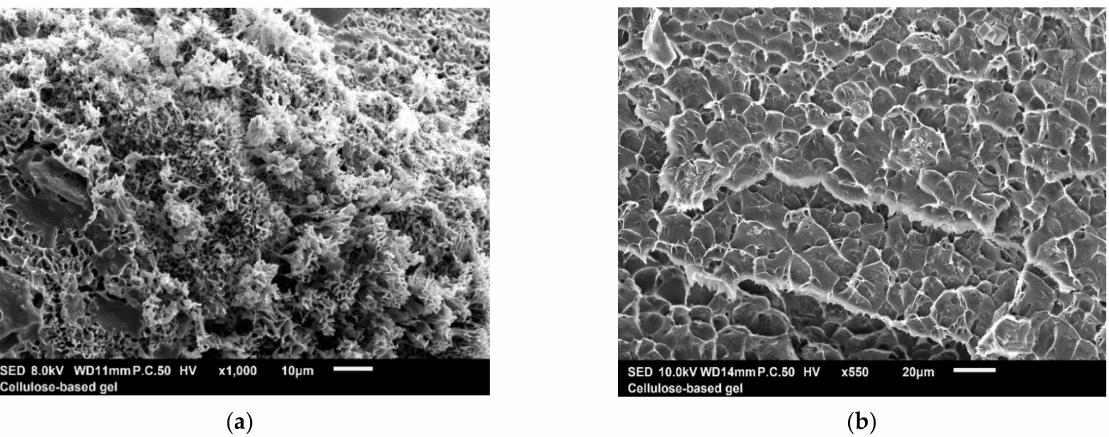
Figure 9. Scanning electron micrographs of PSt composites formed with Sigmacell-m: ( a ) Sample swollen in chloroform and then cryo-fractured. Working distance 11 mm, OA 1, magnification 1000 × ; ( b ) Sample cryo-fractured in dry state. Working distance 14 mm, OA 1, magnification 550 × .